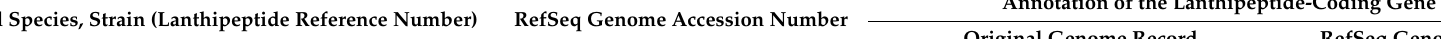
Table 1. Bacterial genomes where a total of eight putative novel class-I lanthipeptides were identified. Annotations of the lanthipeptide-coding gene in the original genome and the RefSeq records are